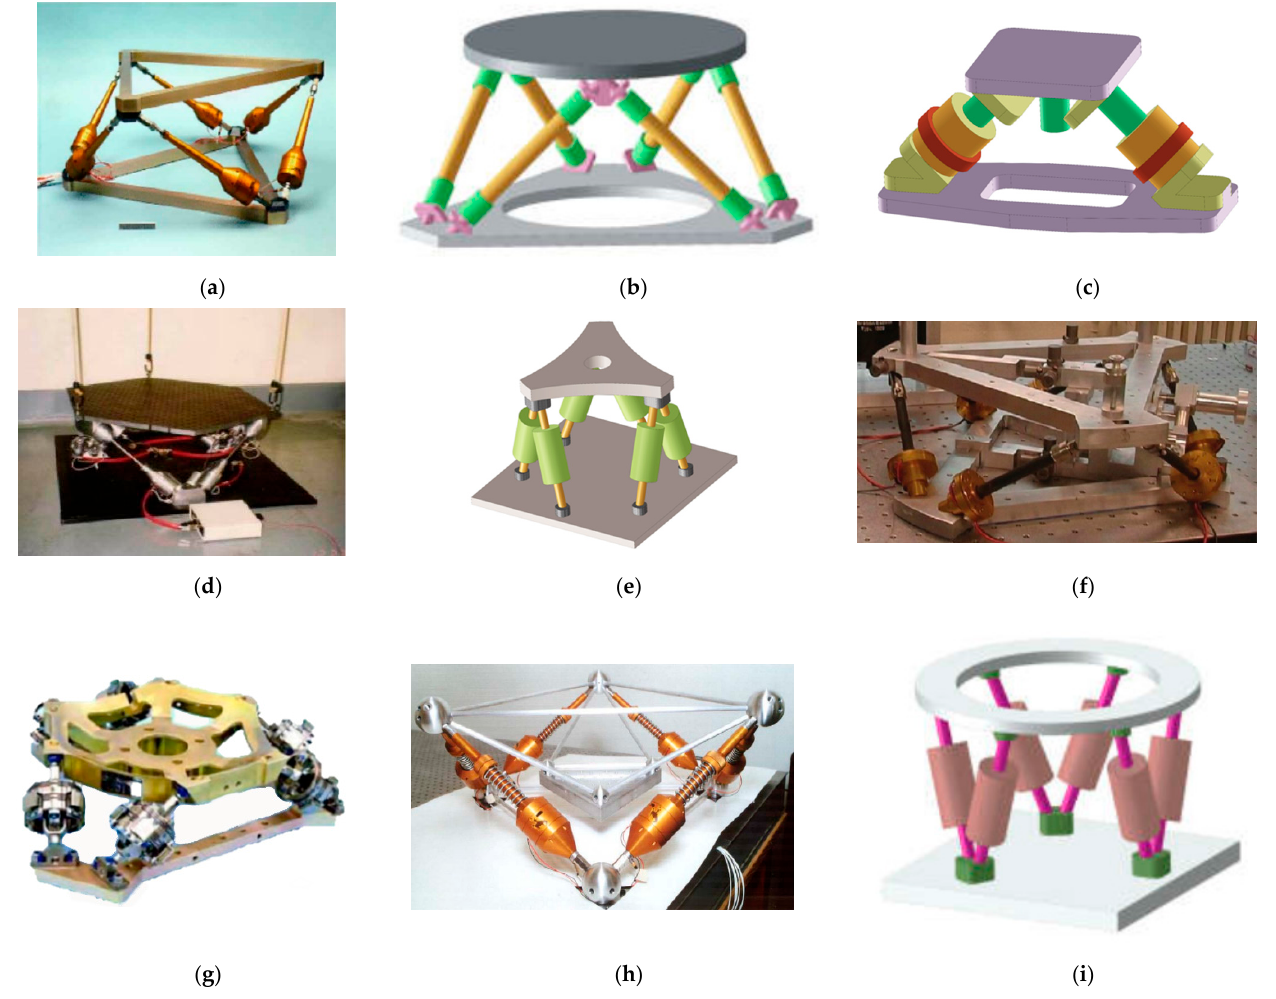
Figure 14. The schematic diagram of a typical flexible Stewart platform: ( a ) JPL flexible Stewart platform (Reprinted/adapted with permission from Ref. [114], 2006, Haomin Lin); ( b ) D–strut flexible Stewart platform; ( c ) MVIS flexible Stewart platform; ( d ) HT/UW flexible Stewart platform (Reprinted/adapted with permission from Ref. [117], 2004, G.S. Hauge); ( e ) PPH flexible Stewart platform; ( f ) ULC flexible Stewart platform (Reprinted/adapted with permission from Ref. [119], 2007, A. Preumont); ( g ) RWIA flexible Stewart platform; ( h ) UW flexible Stewart platform (Reprinted/adapted with permission from Ref. [114], 2006, Haomin Lin); ( i ) NPS flexible Stewart platform.